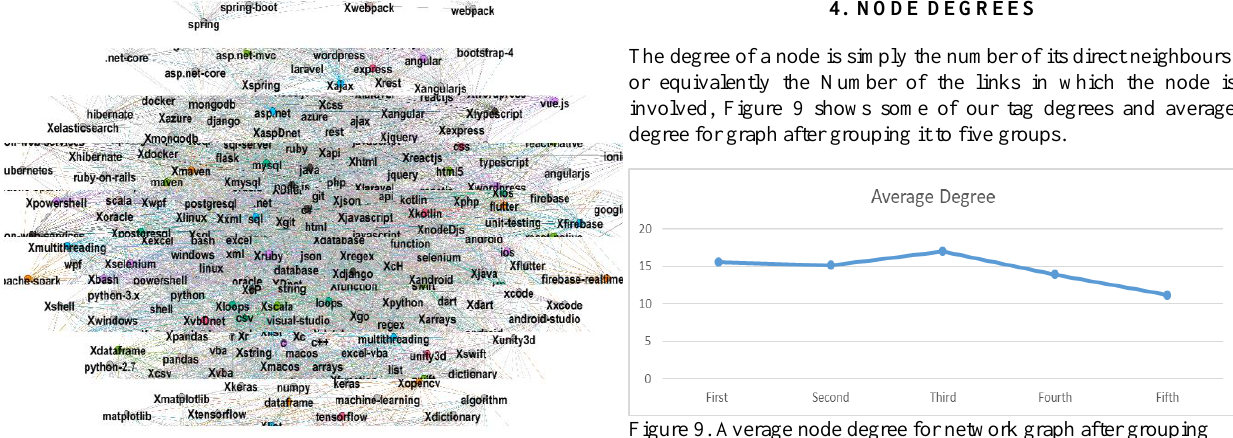
Figure 9. Average node degree for network graph after grouping